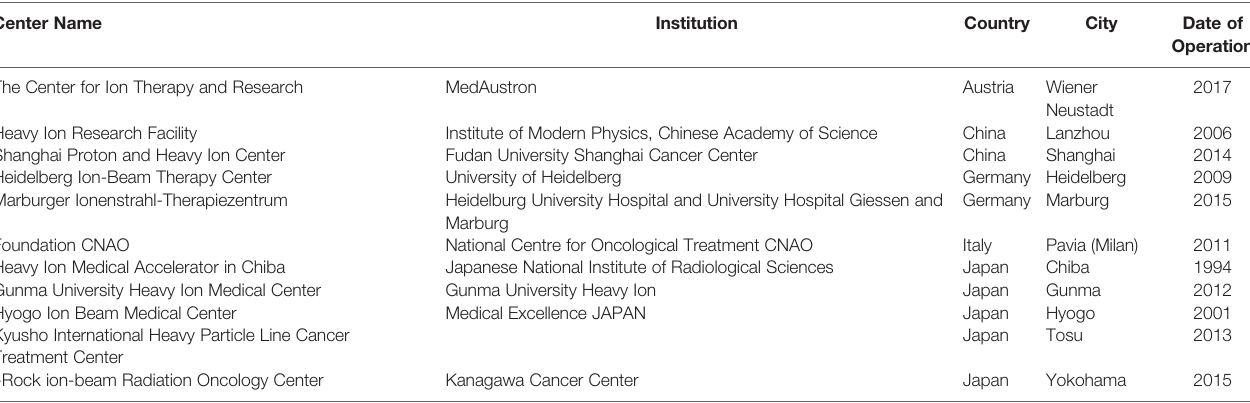
TABLE 4 | Carbon-Ion centers worldwide (a)(b).